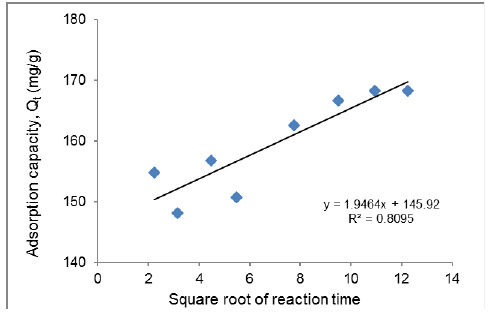
Fig. 9. The plot of Q versus for the adsorption of t iodine on ASL-2